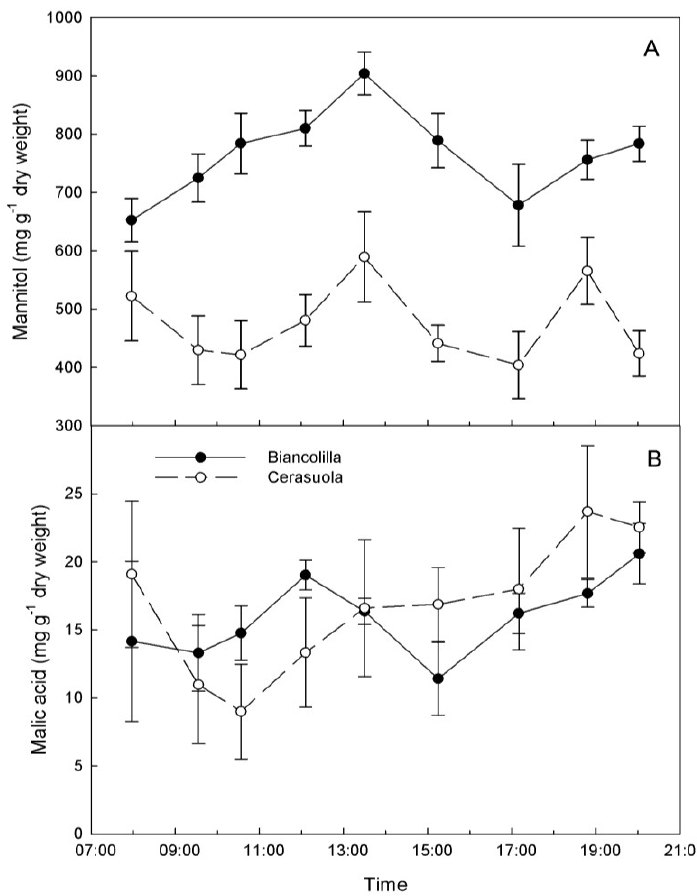
Figure 3. Diurnal changes of ( a ) mannitol and ( b ) malic acid in leaves of ‘Biancolilla’ and ‘Cerasuola’ olive trees during a typical summer day in Sicily. Error bars represent standard errors of